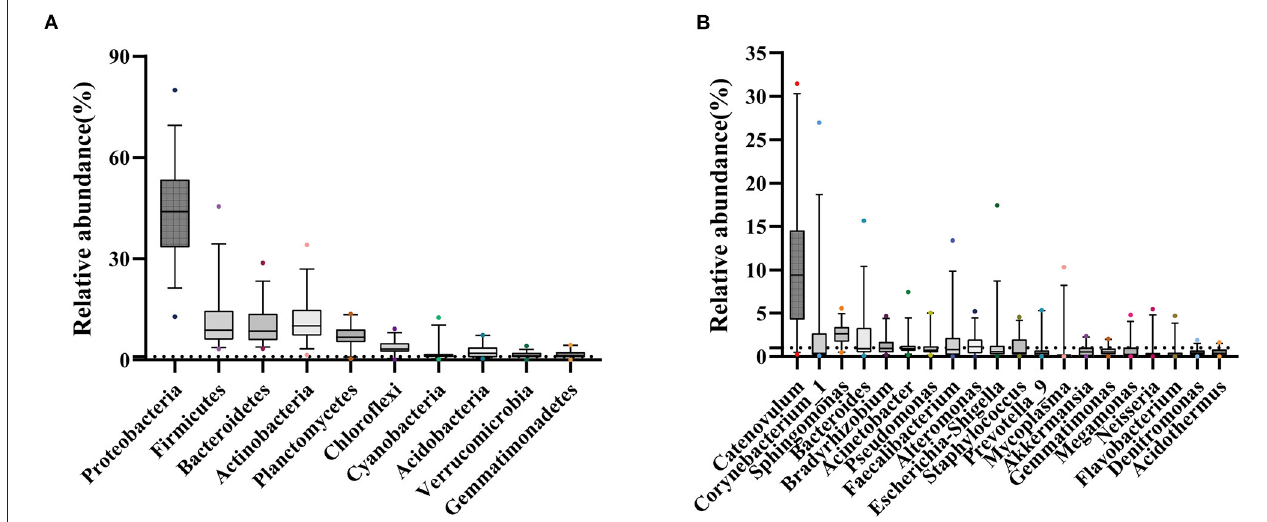
FIGURE 3 | Sample distribution of relative abundance of bacteria at different taxonomic levels. (A) Top 10 at phylum levels. (B) Top 20 at genus levels.